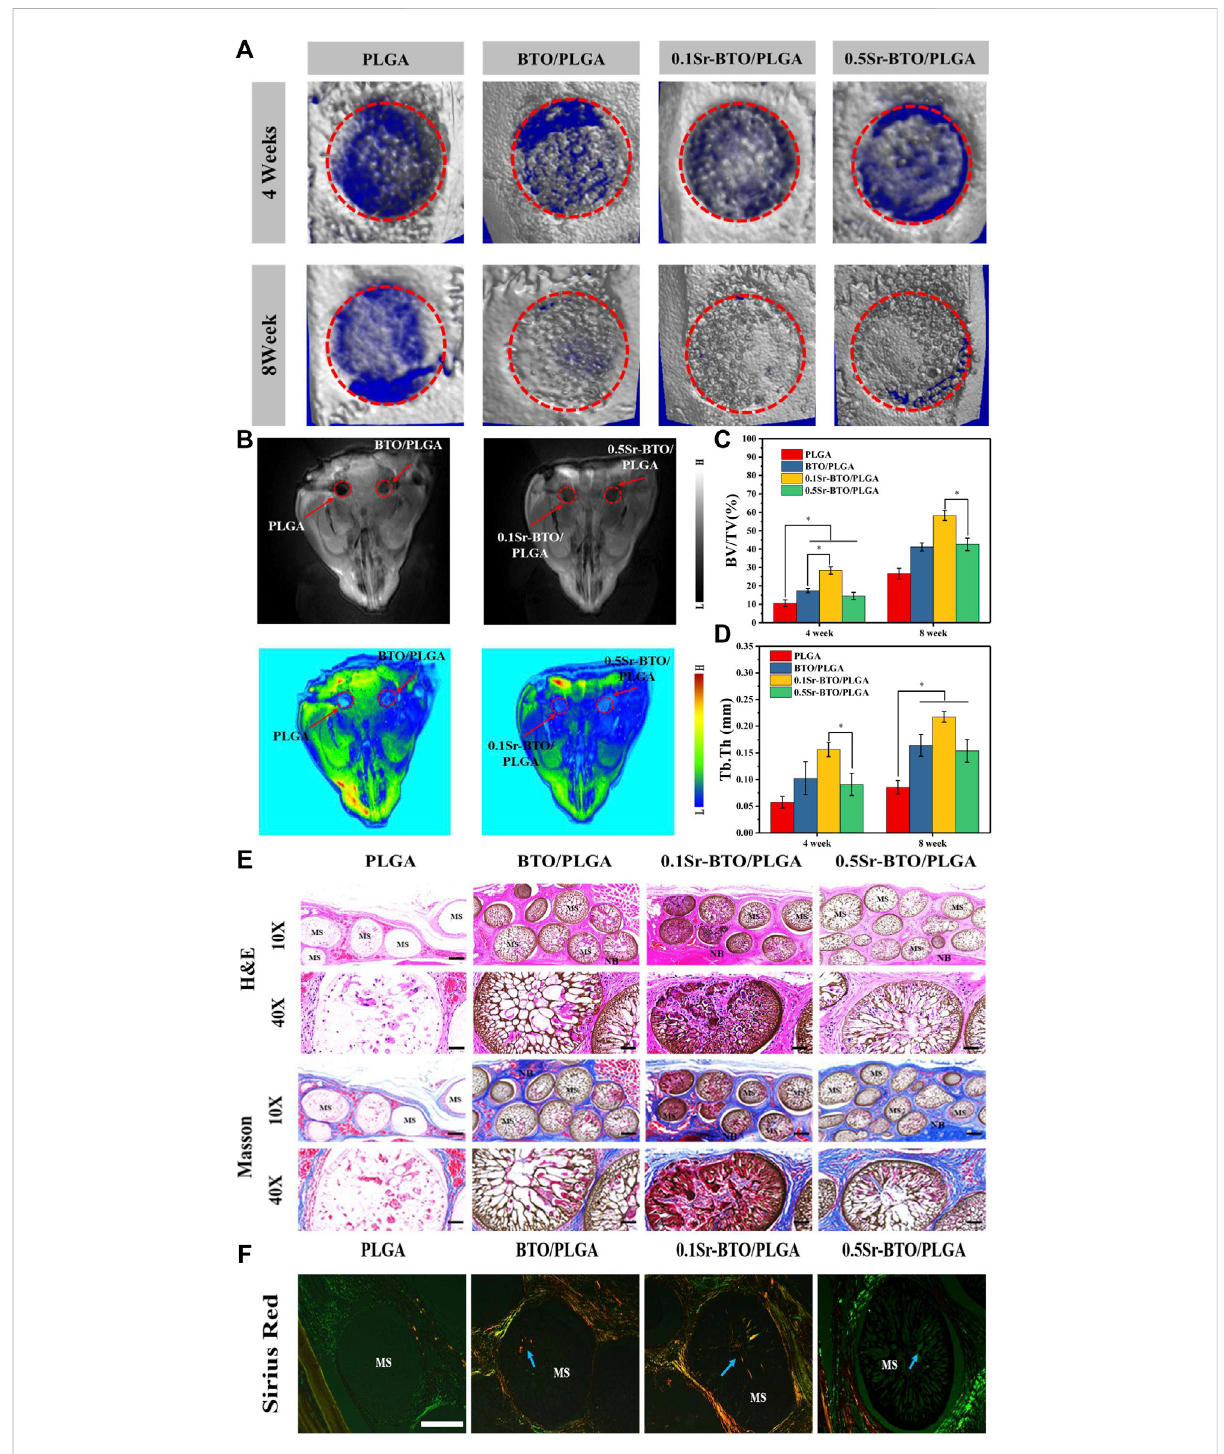
FIGURE 10 (A) 3D reconstructed micro-CT image of sagittal sections of bone formation at the rat calvarial bone defect areas due to implantation with different microspheres at 4 and 8 weeks. (B) In vivo T1-weighted grey-scale MRI image and the corresponding pseudo-color MRI image of bone formation at the rat calvarial bone defect areas due to the implantation with different samples at 8 weeks. (C) The quantitative micro-CT bone parameters of bone volume/tissue volume (BV/TV) ratio and (D) trabecular thickness (Tb.Th) at 4 and 8-weeks post-implantation in the experimental rat skull. *p < 0.05. (E) Histological analysis of Hematoxylin-Eosin (H,E) stained sections and Masson Trichrome staining in rat calvarial bone defect areas at 8 weeks post-surgery at 10x (Scale bar: 200 μ m) and 40x (Scale bar: 50 μ m) (F) Sirius Red staining of microsphere implanted in rat calvarial bone defect areas at 8 weeks post-surgery. (Scale bar: 200 μ